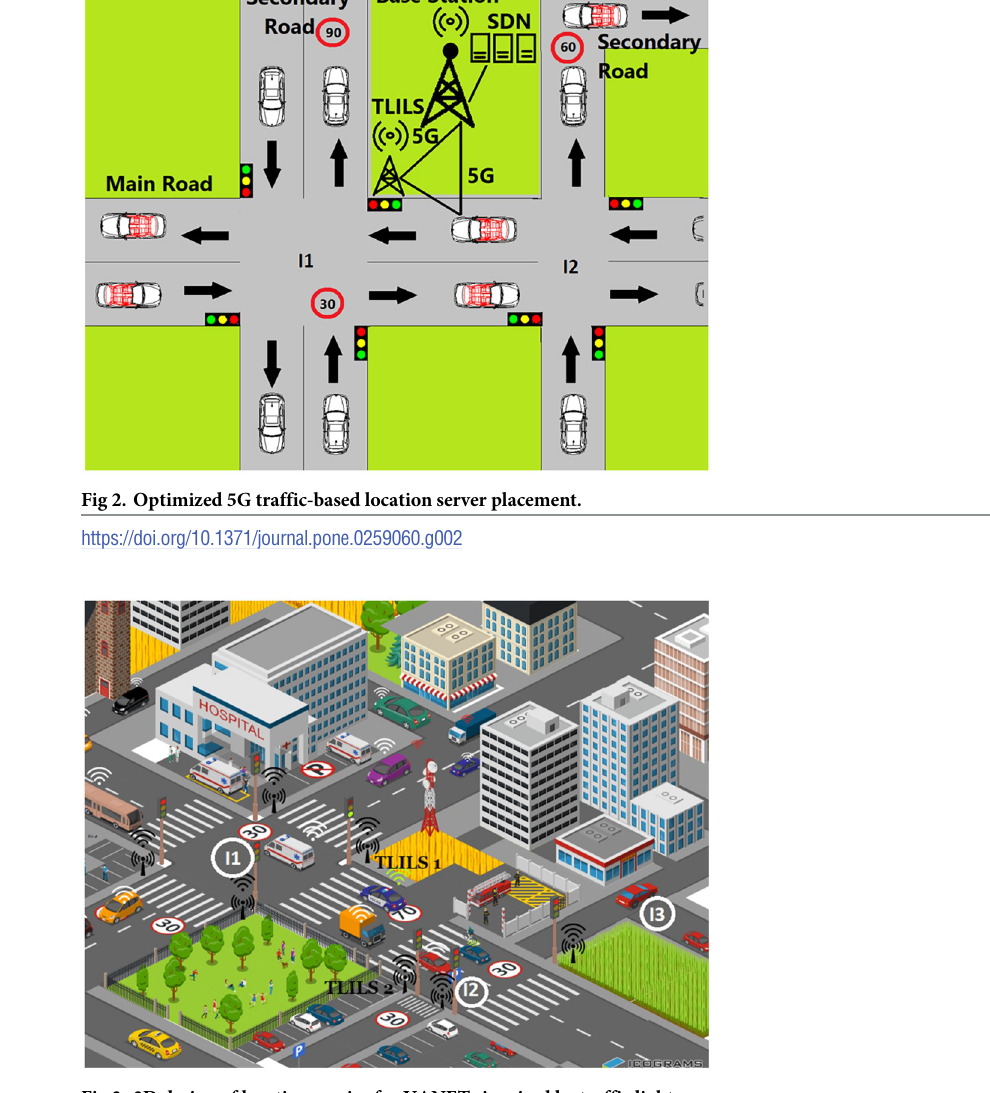
Fig 3. 3D design of location service for VANETs inspired by traffic lights.